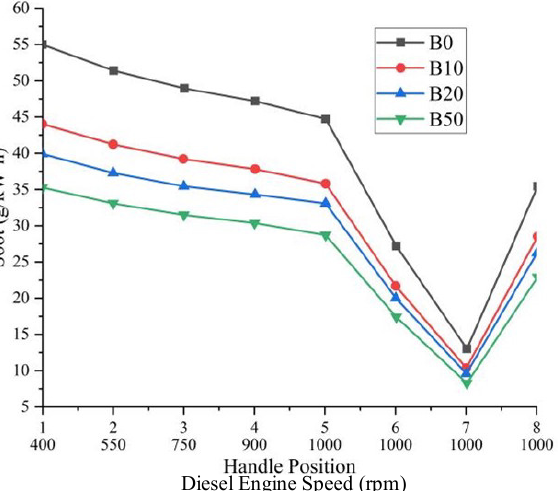
Figure 7. The soot curve of biodiesel with different ratios under various working conditions.